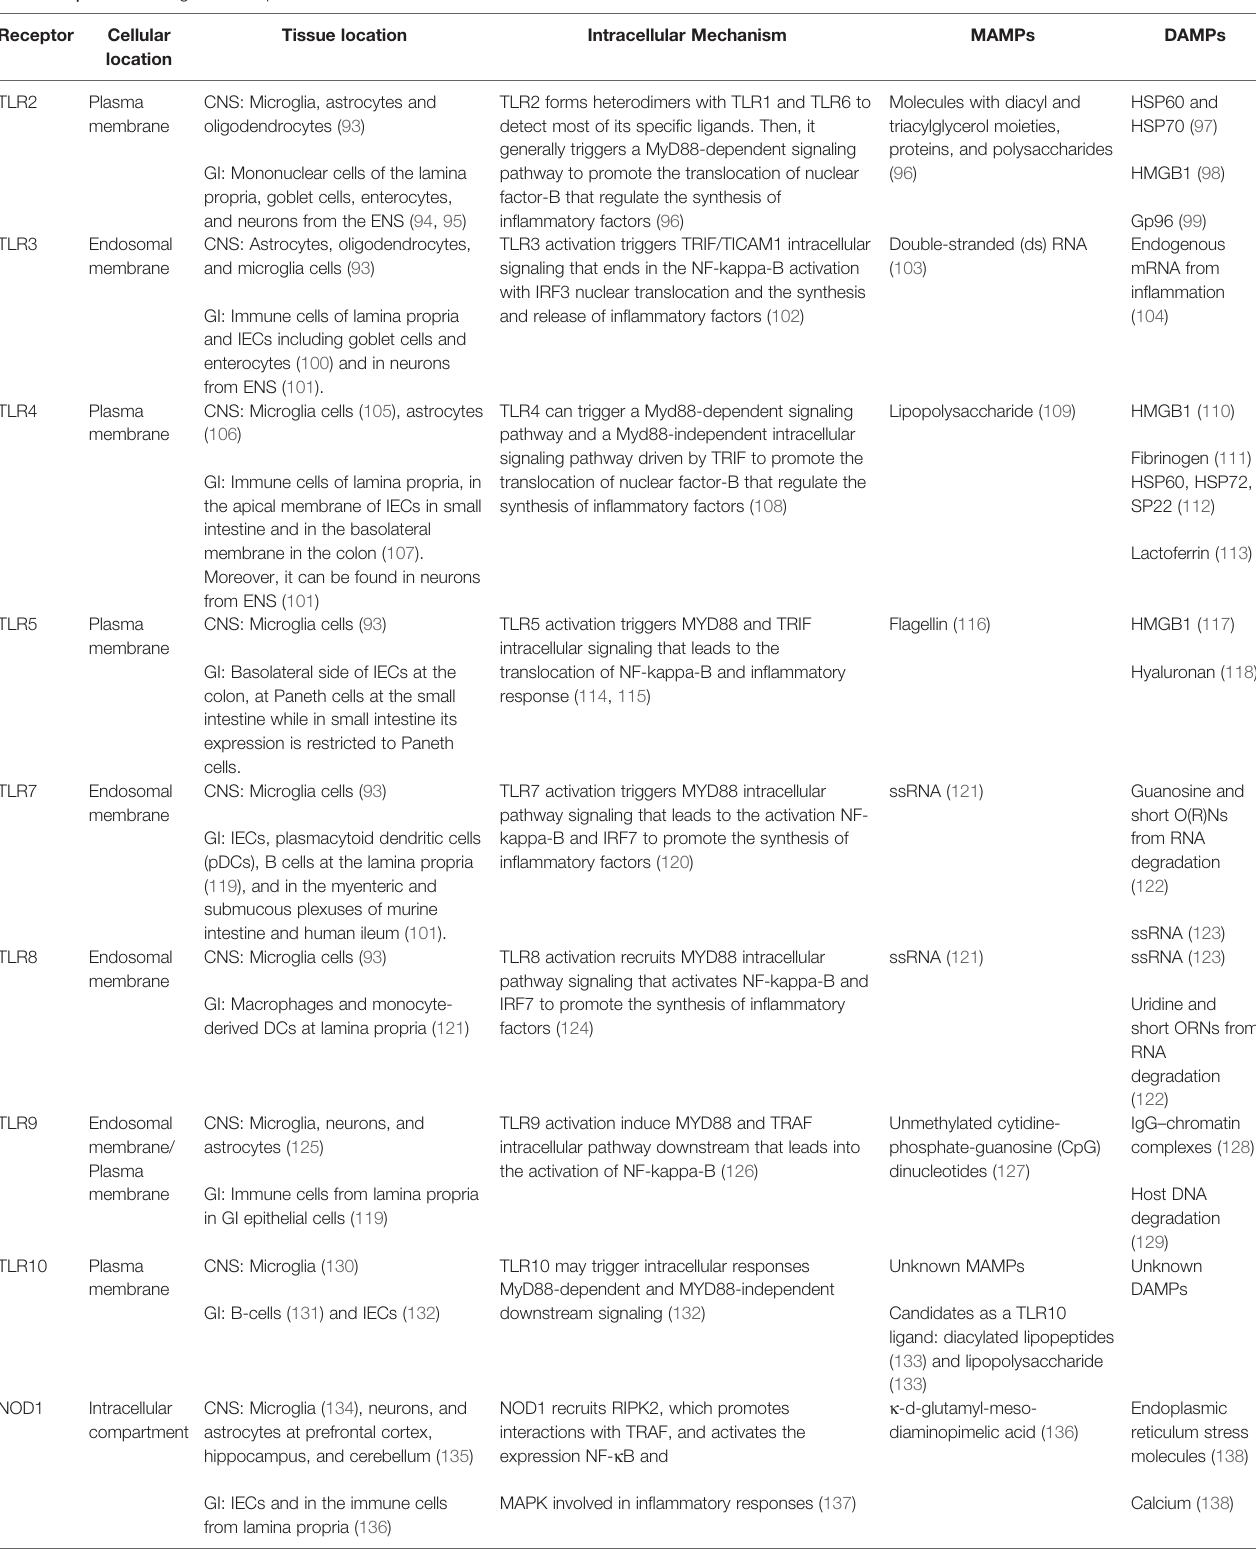
TABLE 2 | Pattern recognition receptors: TLRs and NLRs.